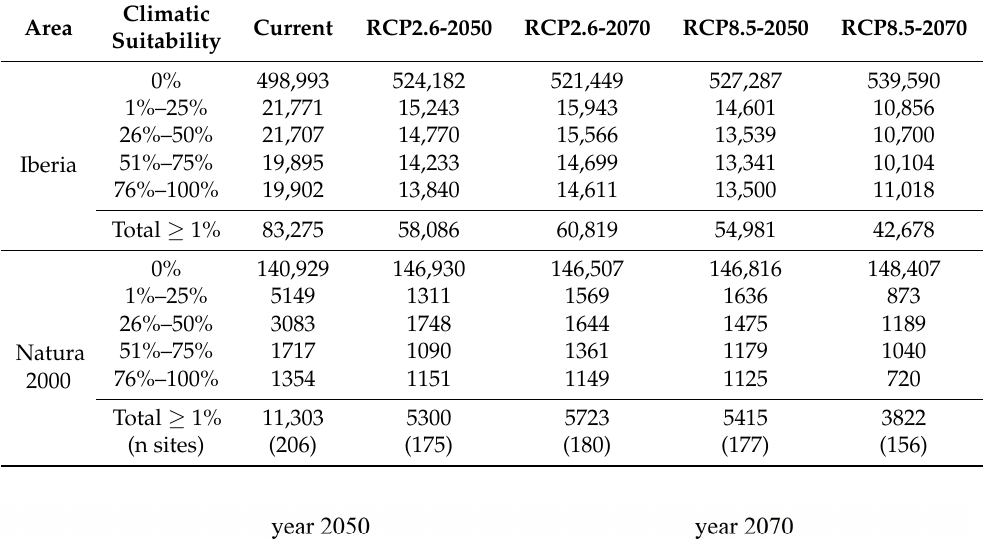
Table 3. Areas (km 2 ) in the Iberian Peninsula and inside Natura 2000 according to levels of climatic suitability for Eucalyptus globulus recruitment for the present and the years 2050 and 2070 under climate change scenarios RCP2.6 and RCP8.5.